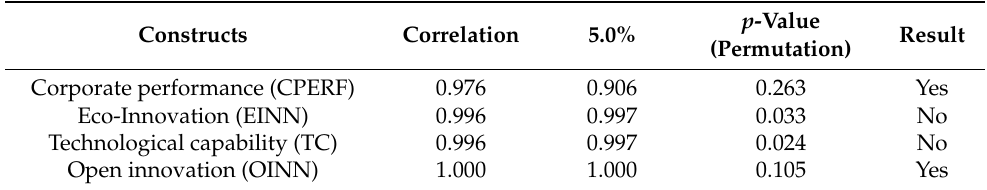
Table 9. Configurational